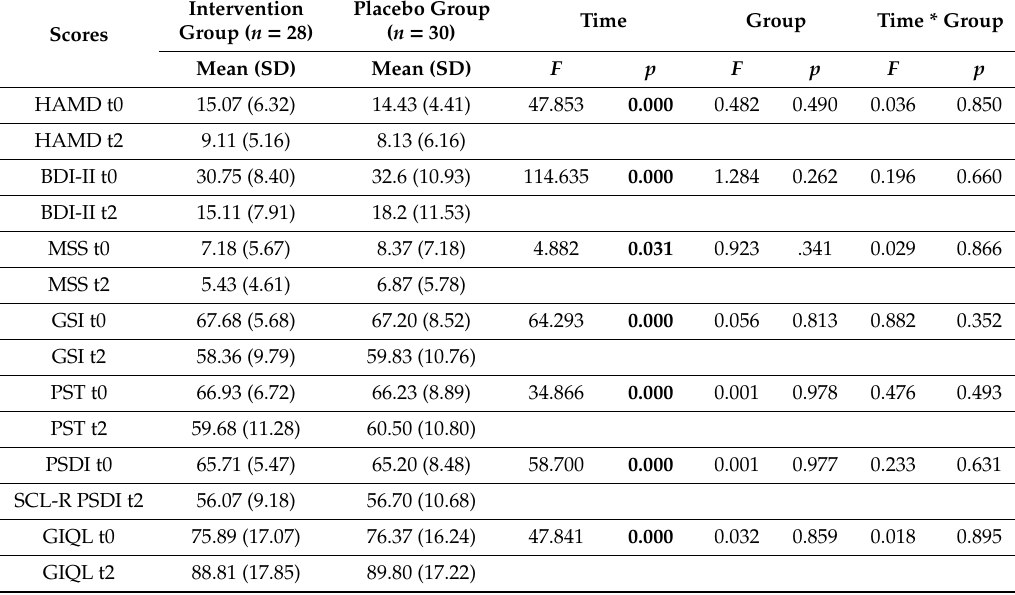
Table 2. Changes in psychiatric scales.